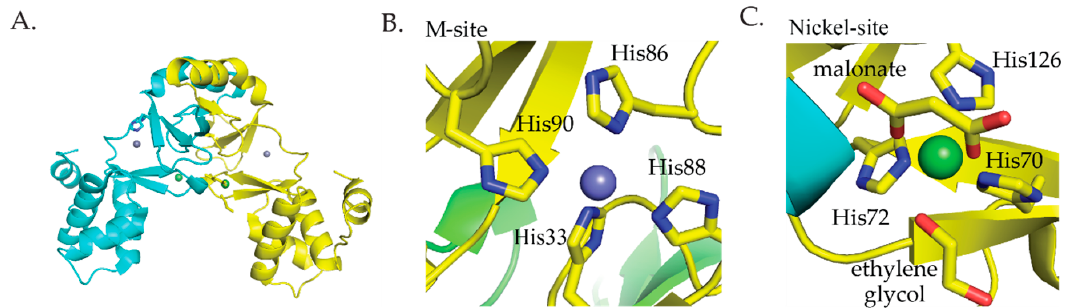
Figure 4. ( A ) The crystal structure of S. coelicolor Nur (PDB ID 3EYY) [62]. The monomers are colored cyan and yellow. Zinc ions and nickel ions are shown as slate spheres and green spheres, respectively.